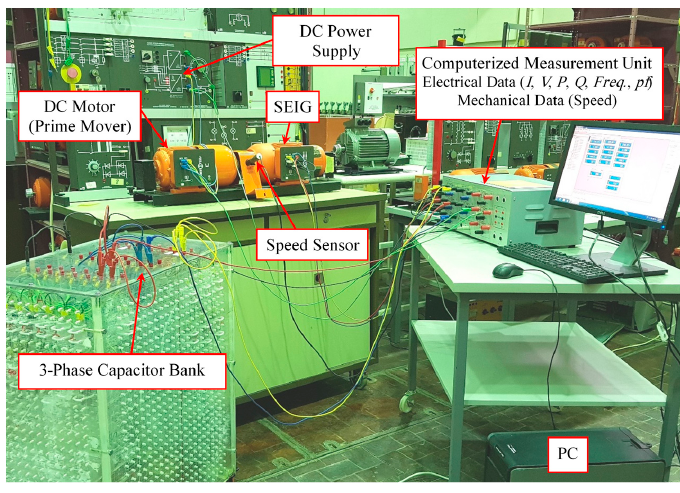
Figure 12. Experimental setup for SEIG testing.